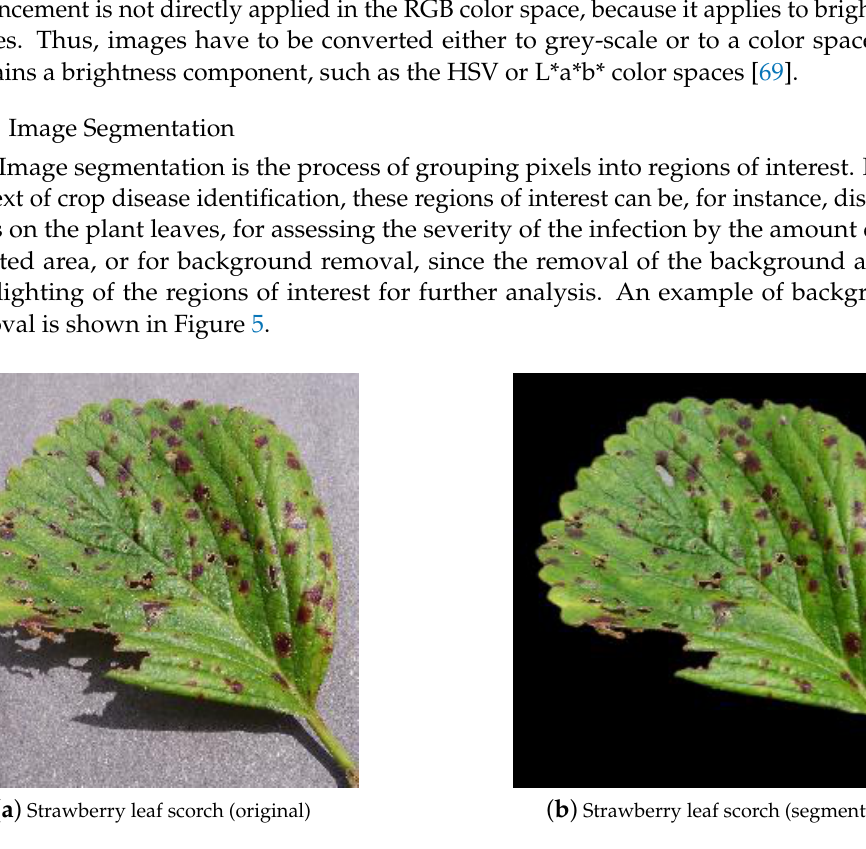
Figure 5. Example of background removal from the PlantVillage data-set